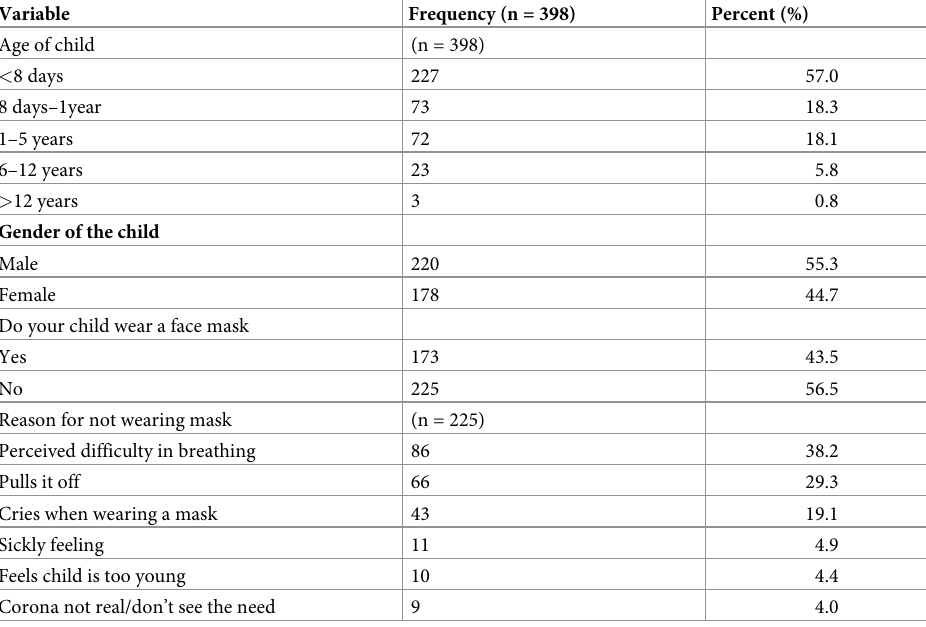
Table 1. Mothers’ perception of masking in